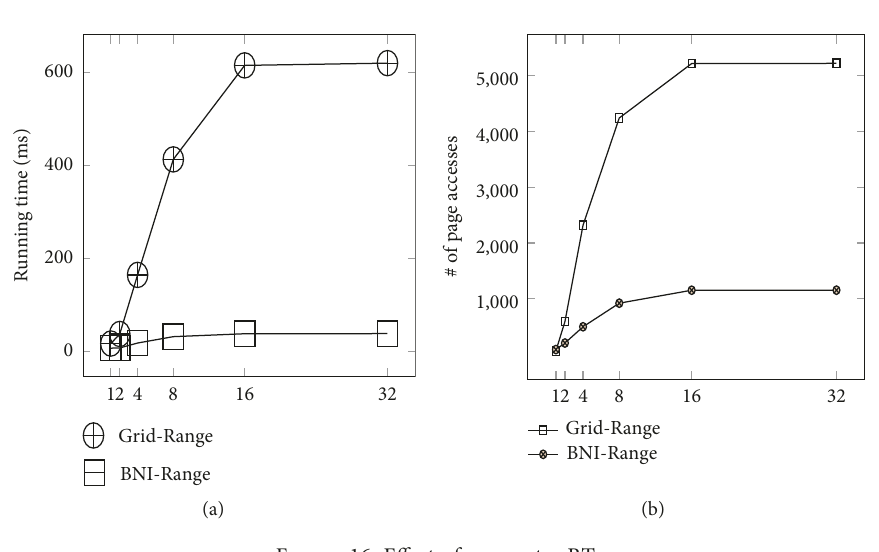
Figure 15: Effect of parameter QK.